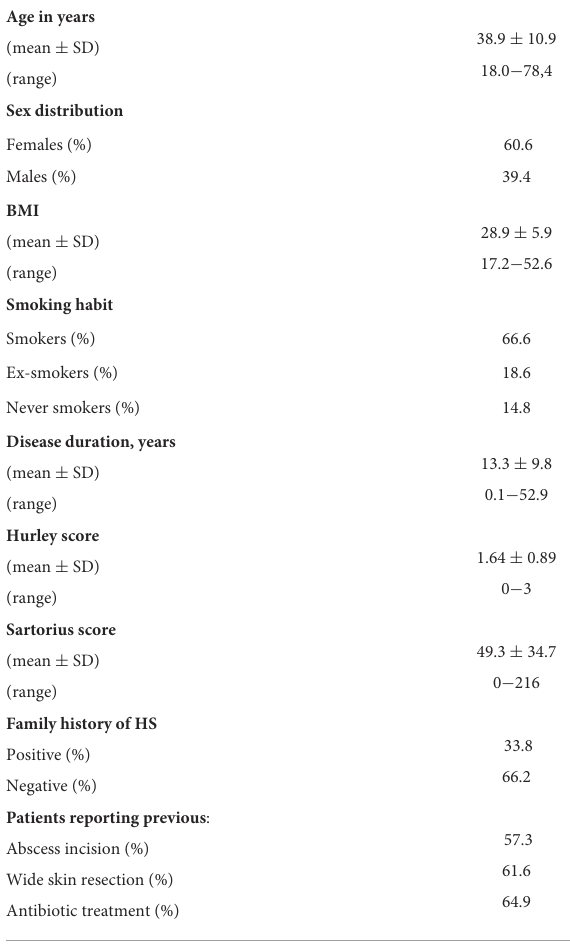
TABLE 1 Demographic and clinical characteristics of the study cohort ( n =